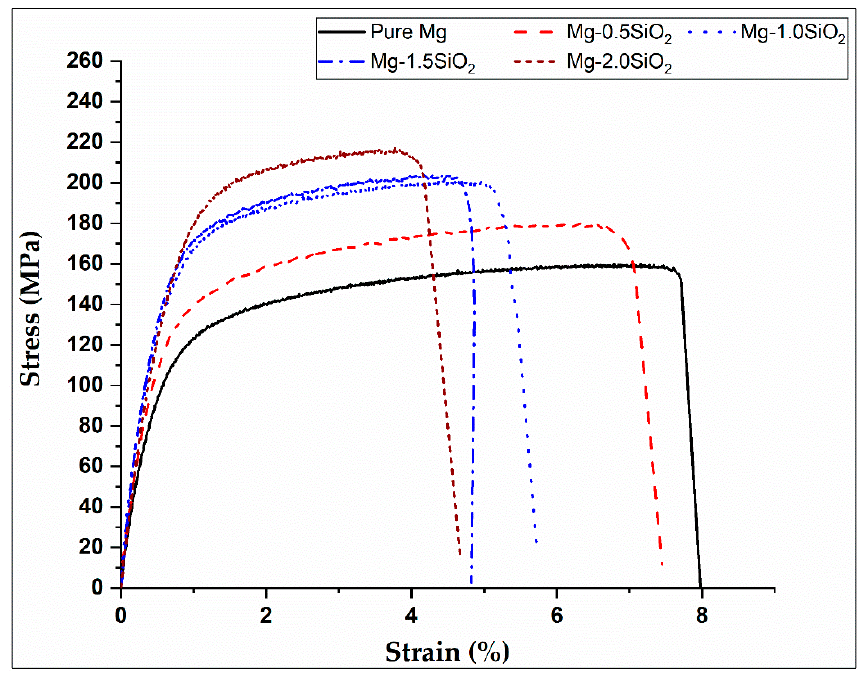
Figure 2. Stress–strain graphs of Mg and Mg-SiO 2 syntactic foams.